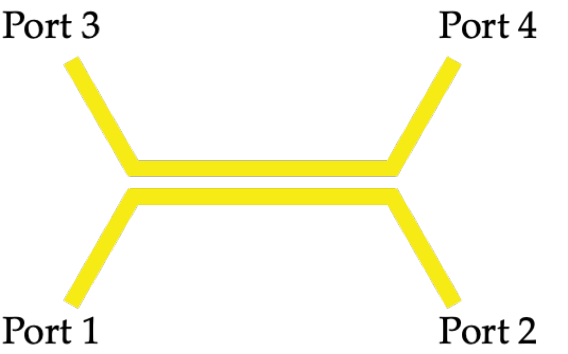
Figure 1. Traditional parallel coupler shape.